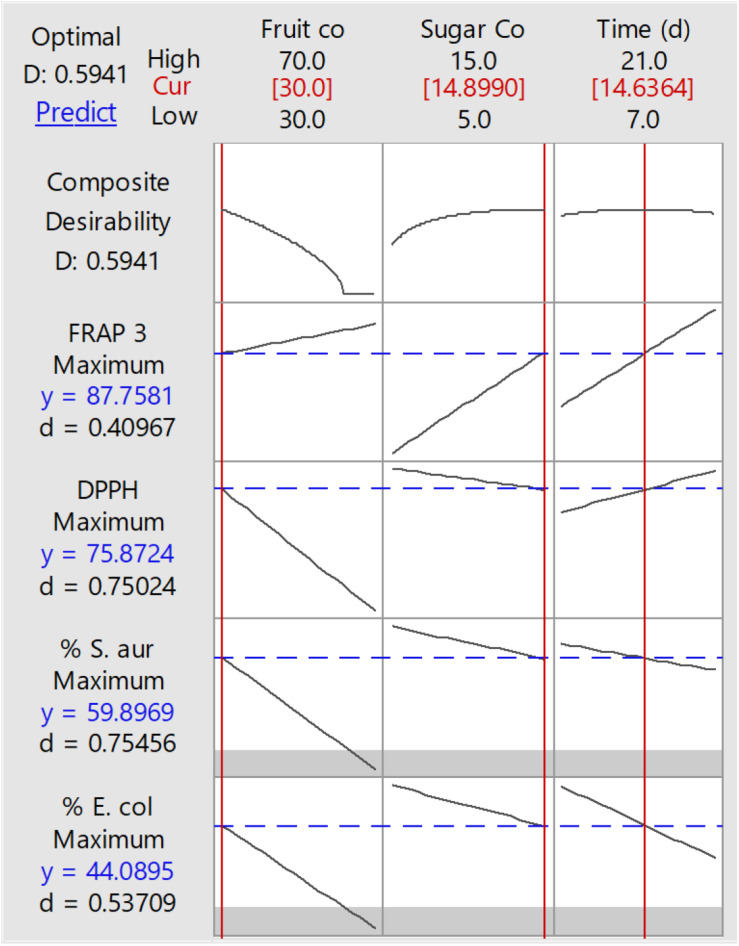
Response surface methodology (RSM) results of optimized conditions to produce soursop kombucha.